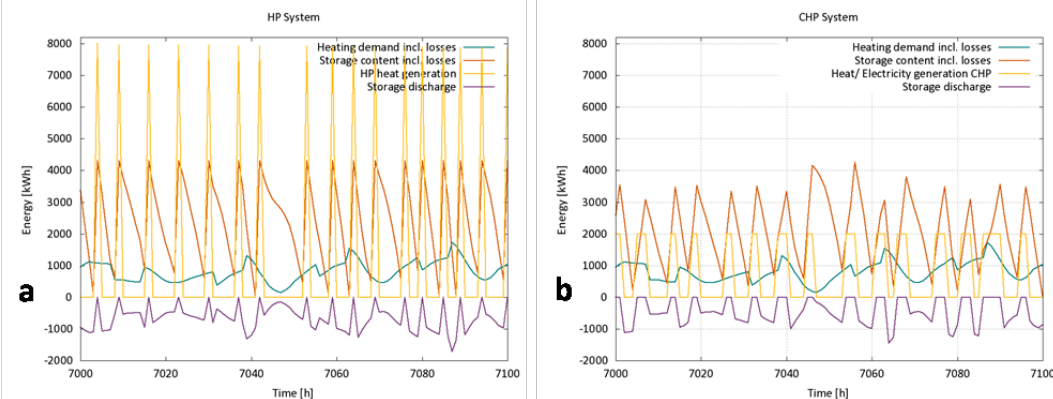
Figure 14. Analysis of the performance of both systems from the hours of the year 7000-7100 (( a ): HP System, ( b ): CHP